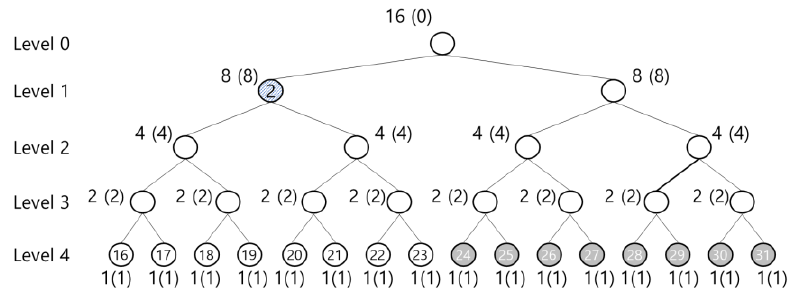
Figure 2. The inefficiency of the MHT-based authentication scheme caused by duplicated processing.